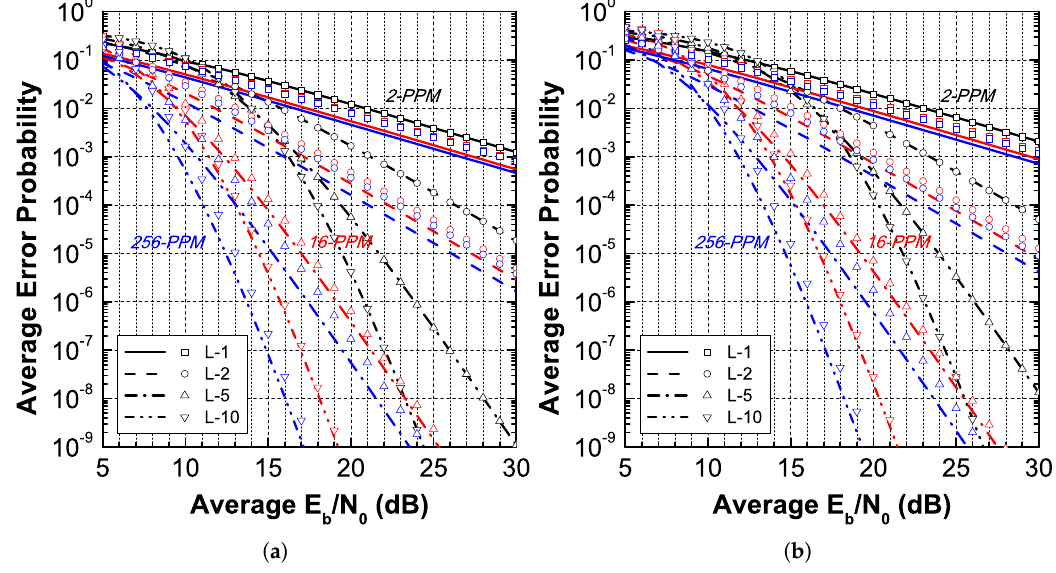
Figure 4. Average PER vs E b / N 0 for Q = 2,16, 256 in strong fading. The plot lines and points correspond to the exact and approximated results, respectively. k = 2 ( a ) and k = 8 ( b